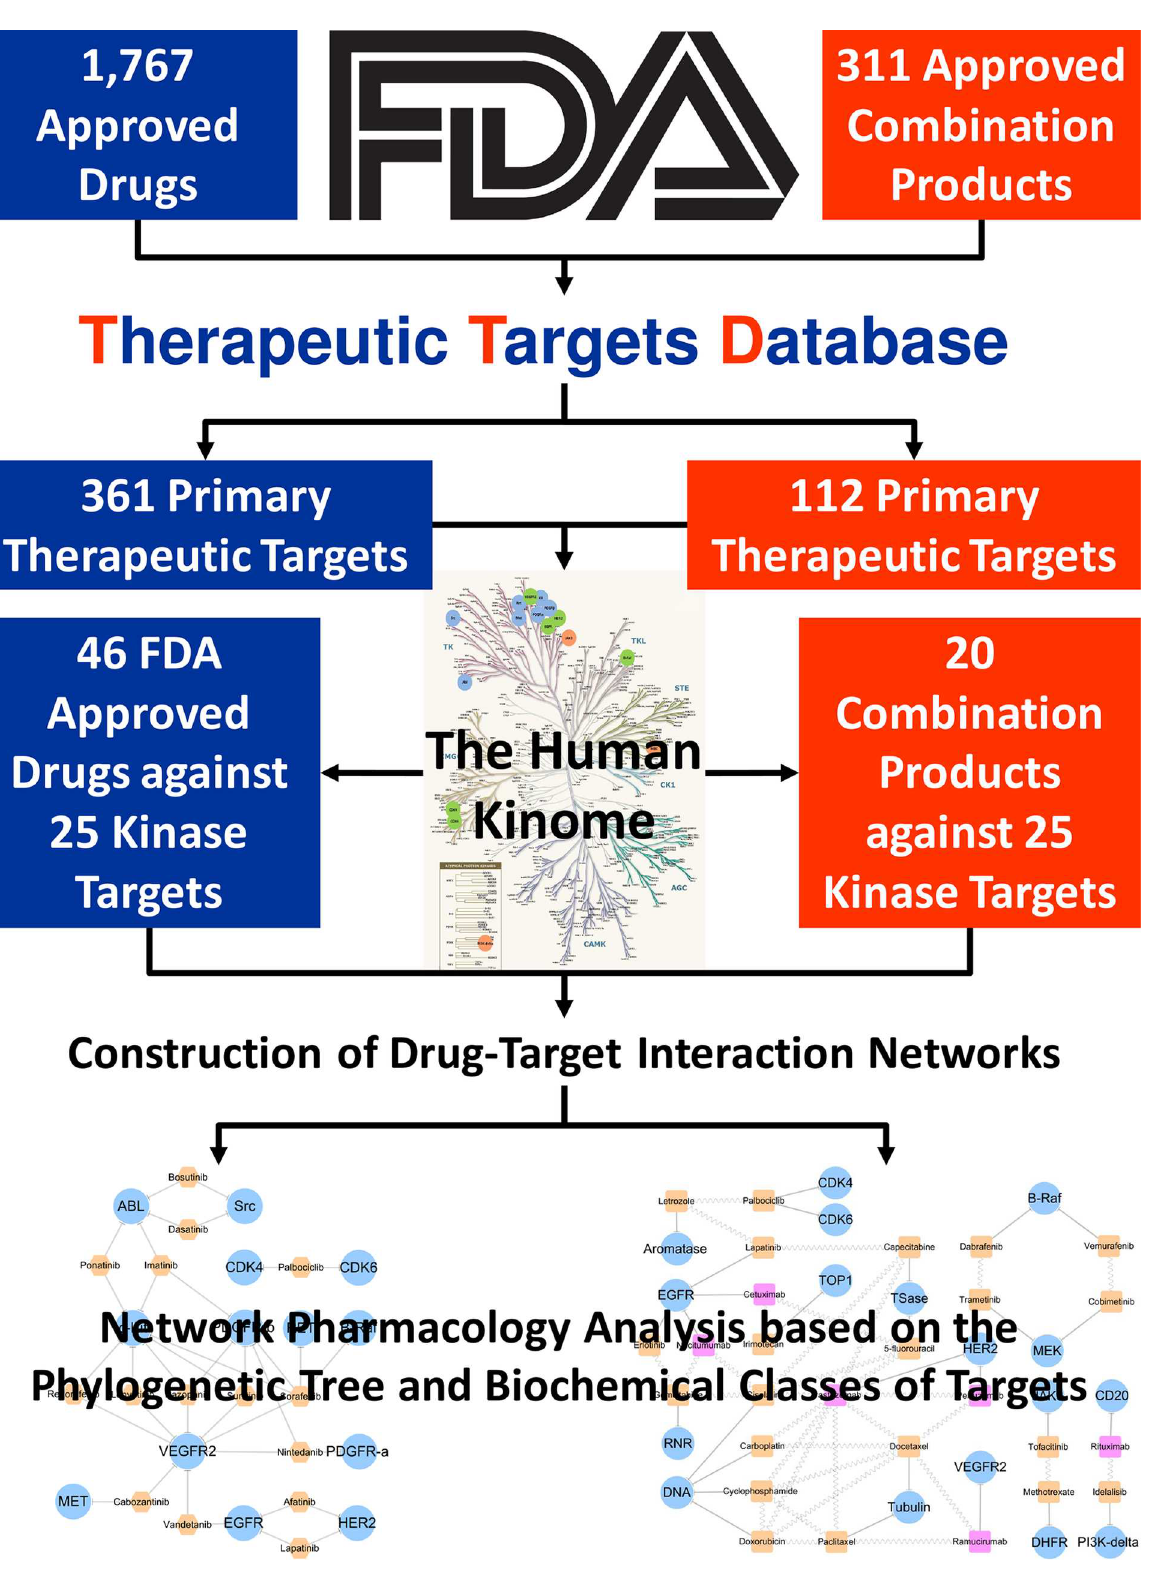
Fig 2. A framework of proposed comparative strategy used in this study.